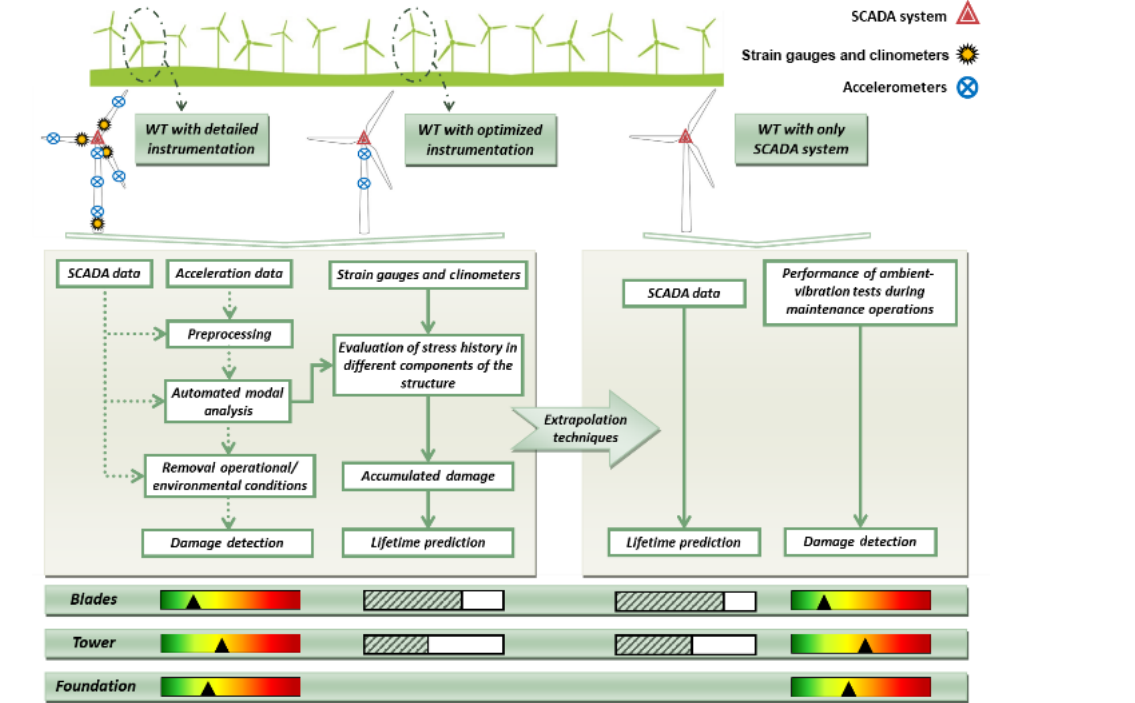
Figure 1. Monitoring strategy. Meaning of the horizontal bars at the bottom: the colour bars represent in a simplistic fashion the structural health; the green and white bars represent the consumed fatigue life.